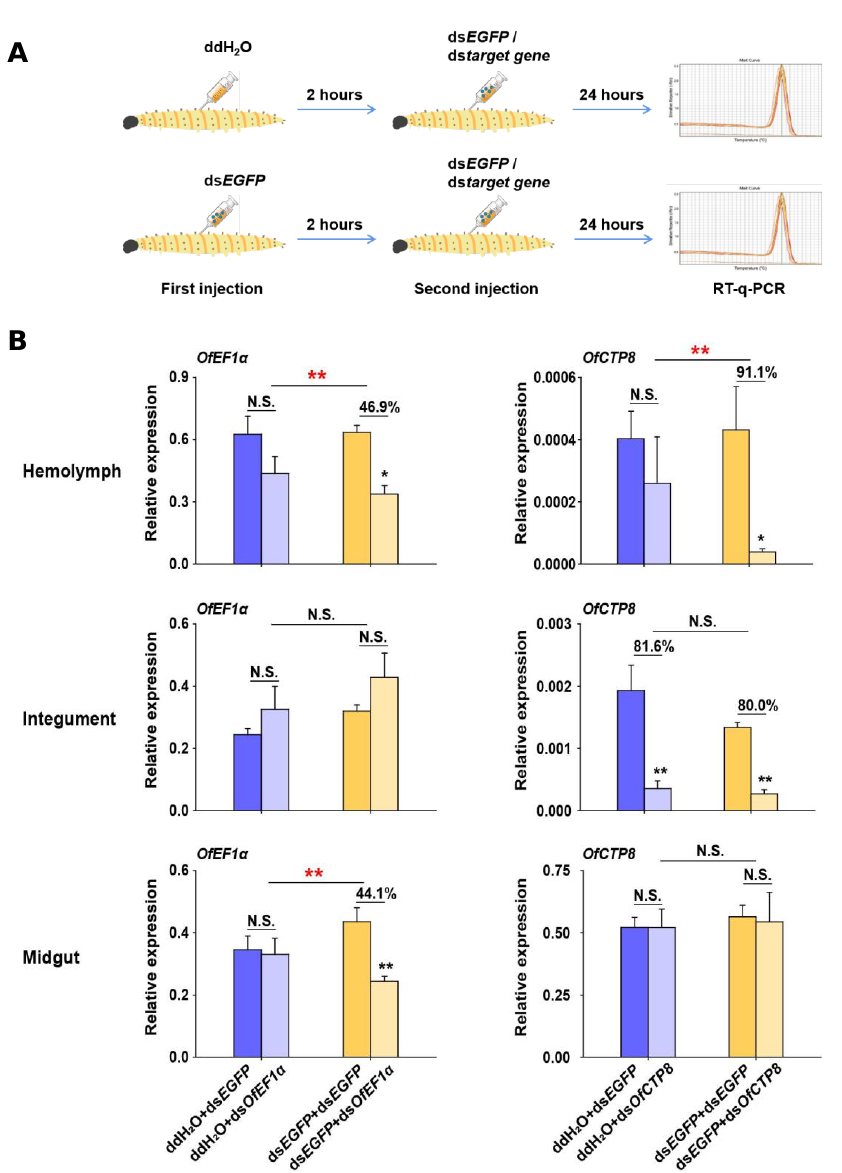
Figure 5. Enhanced RNAi efficiency by pre-injection of ds EGFP in different tissues of O. furnacalis . ( A ) Overview of the experimental setup. ddH 2 O or ds EGFP was pre-injected into larvae (L5D2). After 2 h, ds EGFP or ds OfEF1 α /dsOfCTP8 was injected into the larvae again. After 24 more hours, RT-qPCR was performed to examine the expression of OfEF1 α or OfCTP8 in different tissues of O. furnacalis . ( B ) Different combinations of dsRNA or ddH 2 O injection were performed for this assay. The statistical significance between control and treatment results was assessed by Student’s t -test. Bars show mean ± SE (* p < 0.05; ** p < 0.01; N.S., nonsignificant) (n =